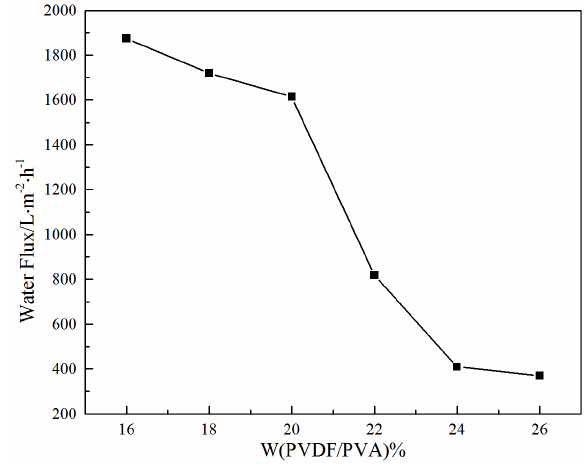
Figure 4. Effect of total polymer concentration on water flux for PVDF/PVA blend membranes S 1 – S 6 .